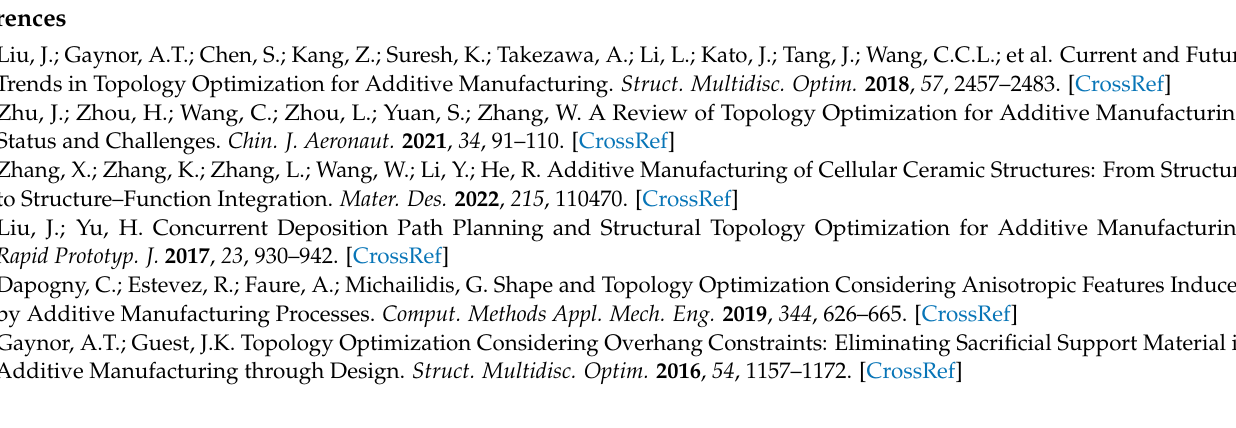
Figure 17. The load-displacement curves from the mechanical tests.